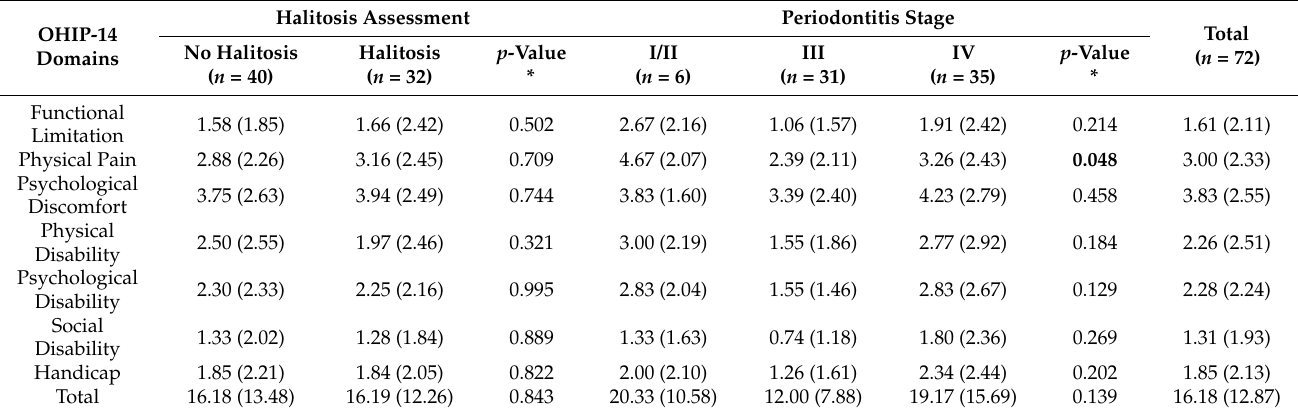
Table 3. Oral-health-related quality of life (OHRQoL) according to halitosis status and periodontal status, presented as a mean (standard deviation) of OHIP-14 domain scores.